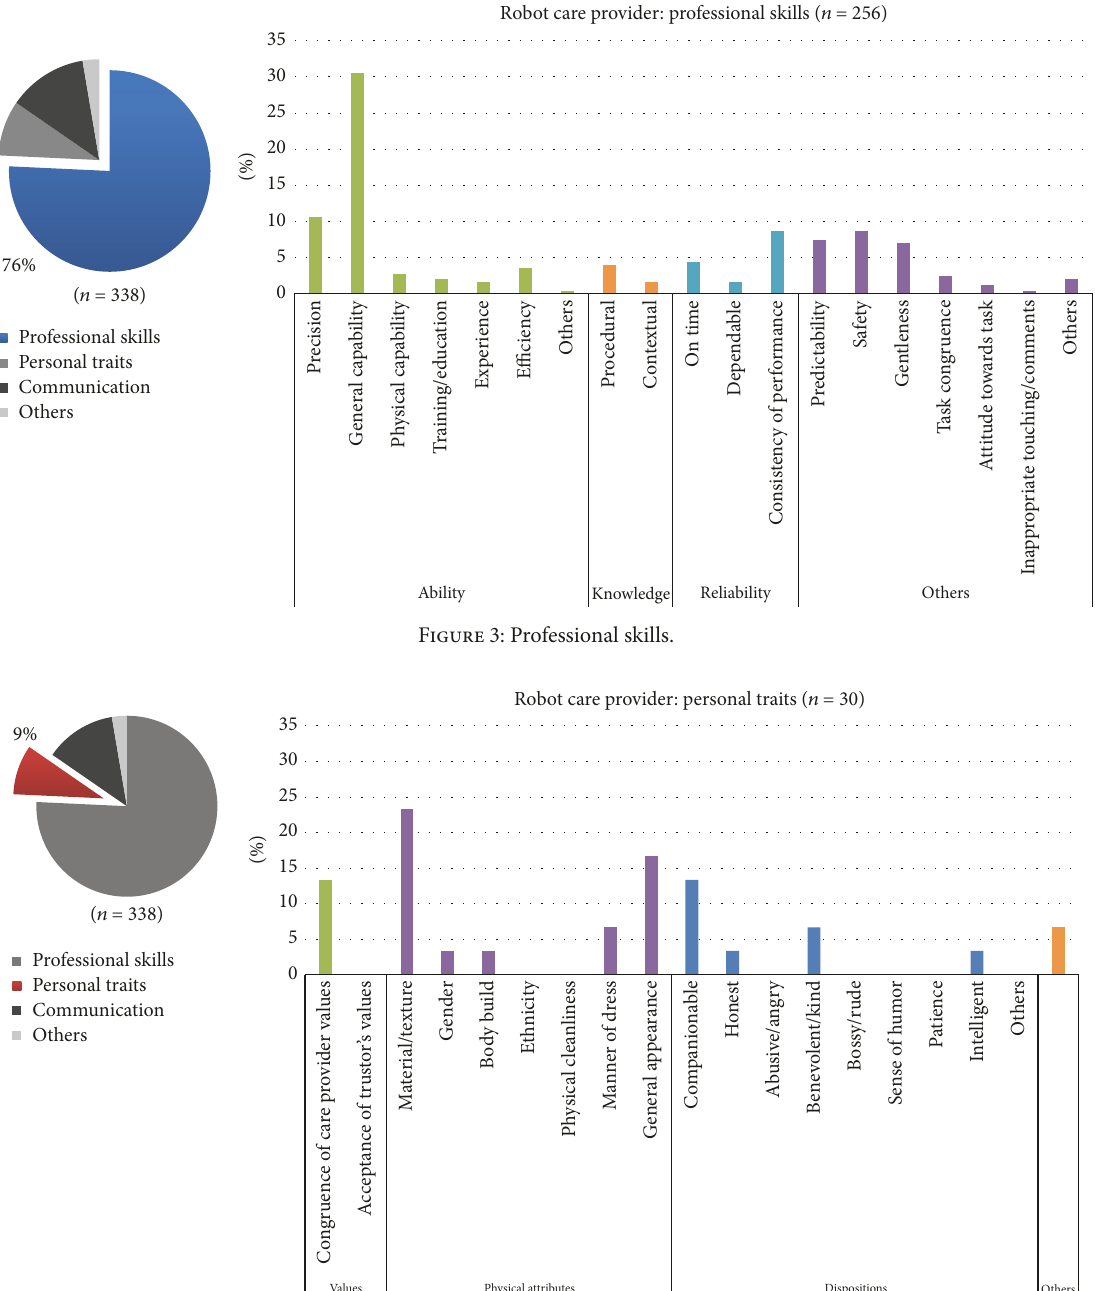
Figure 3: Professional skills.